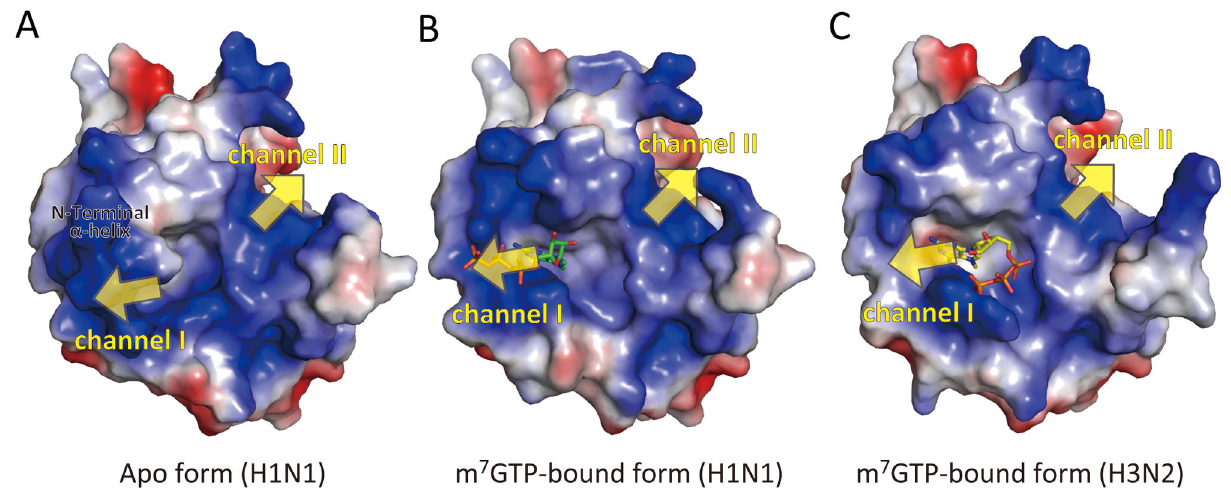
Figure 6. Electrostatic surfaces of the PB2 middle domain. A) Apo form and B) m 7 GTP-bound form in H1N1 and C) m 7 GTP- bound form in H3N2. The molecular orientation is the same as bottom view in Figure 1 and Figure 3. Yellow arrows show the channels, which might bind the continuous RNA. Electrostatic surfaces were calculated and displayed using